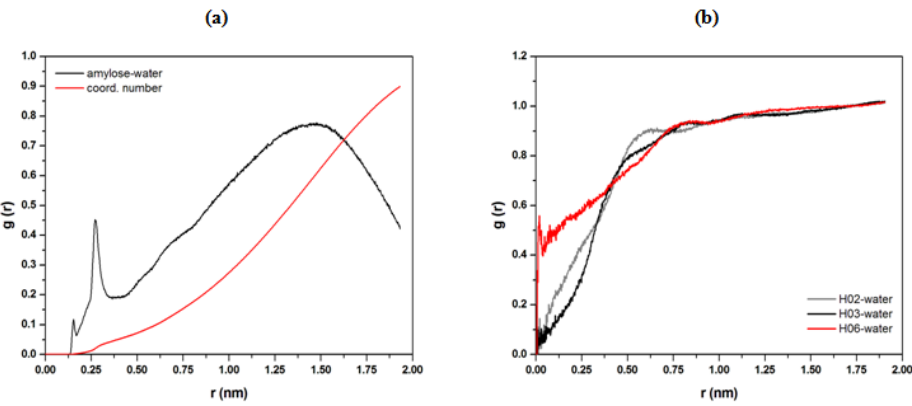
Figure 6. Center-of-mass radial distribution function (COM-RDF) of water molecules around the amylose structure ( a ) and specific COM-RDF of a hydrogen atom in amylose toward water molecules’ interaction ( b ). The g(r) represents the probability of finding an atom or molecule around a distance r of another chosen atom or molecule as a reference point.